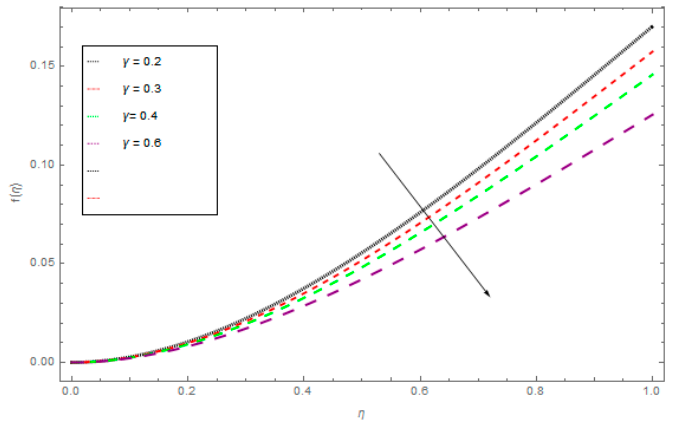
Ω = 1, ρ = 1, σ = 0.5, k = 1, M = 1. Coatings 2019 , 9 , x FOR PEER REVIEW